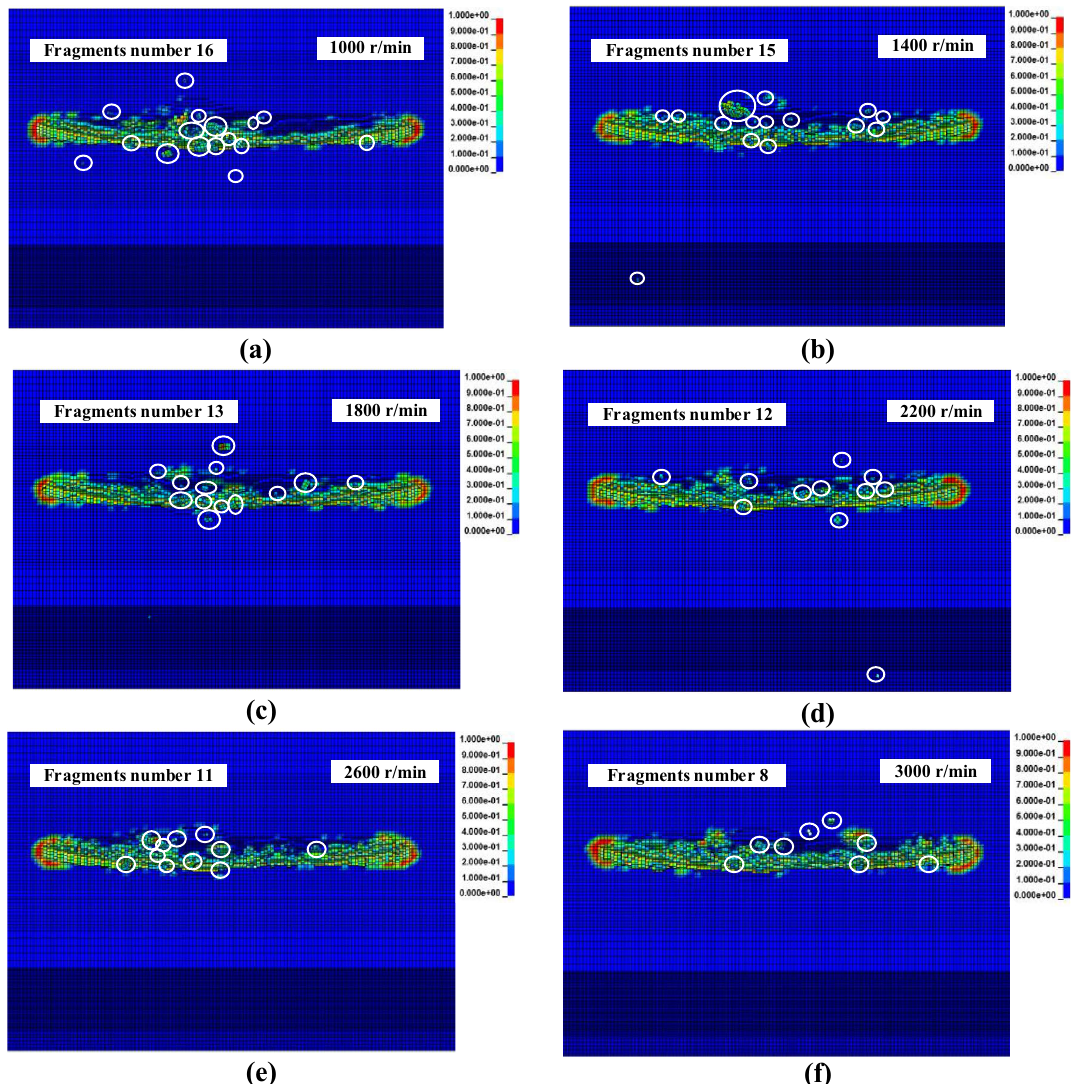
Figure 10. Rock fragments from the circular saw blade cutting at various rotational